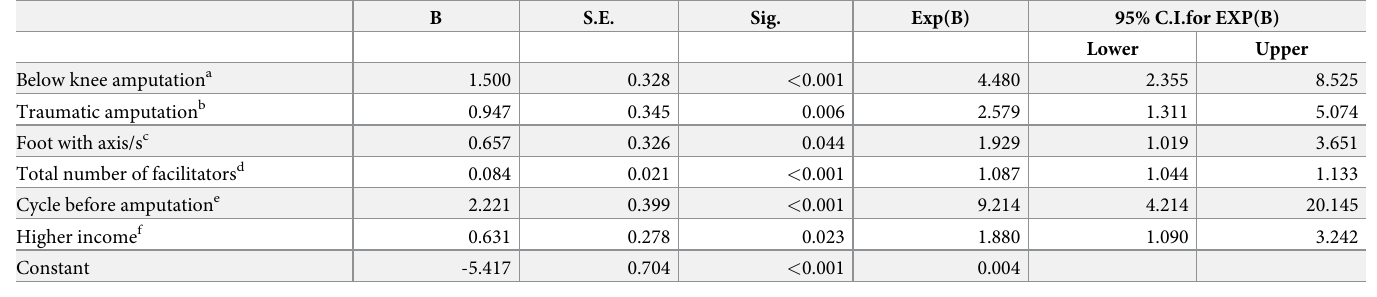
Table 7. Logistic regression of variables associated with cycling